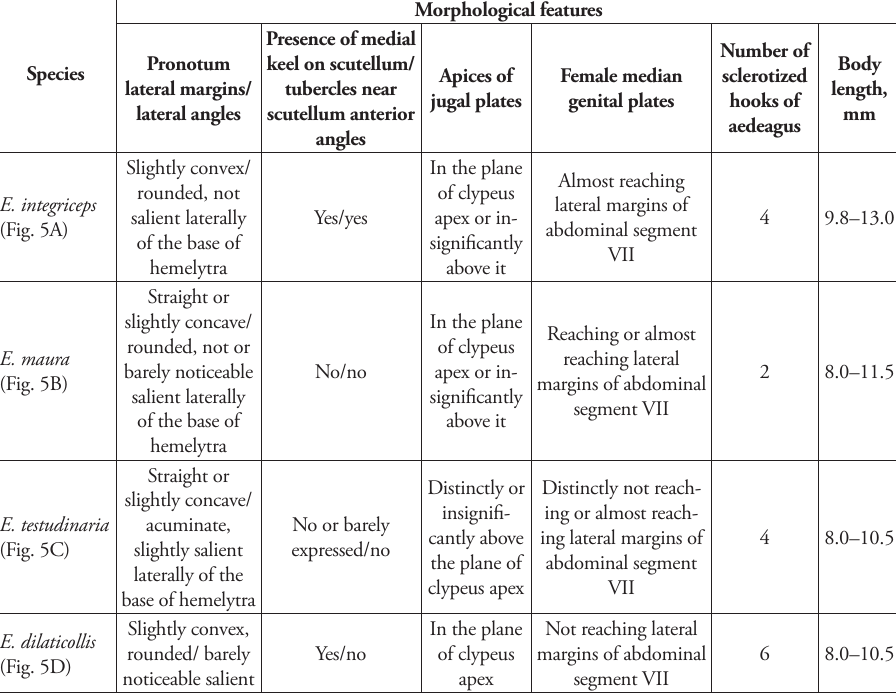
Table 2. Morphological features of E. integriceps , E. maura, E. dilaticollis, and E. testudinaria .